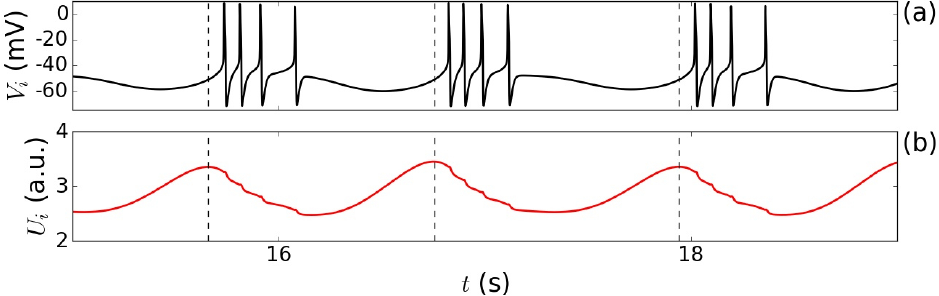
Figure 1. ( a ) Evolution of the dynamic behavior of the membrane potential V i for the Hodgkin–Huxley-type model using the constants defined in Table 1. ( b ) The recovery variable U i ≡ 1/ α i ,sa computed for each neuron, where the maximum of U i corresponds to the beginning of each